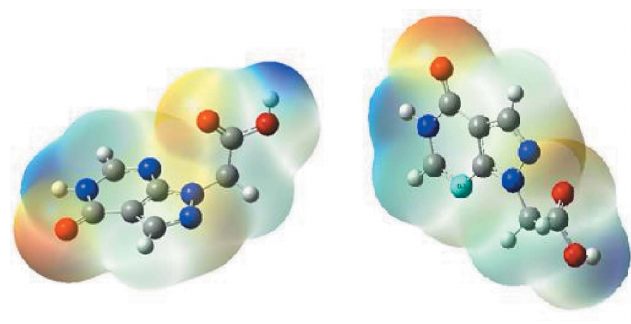
Figure 11 MEP surfaces of (I) mapped at the B3LYP/6–311G